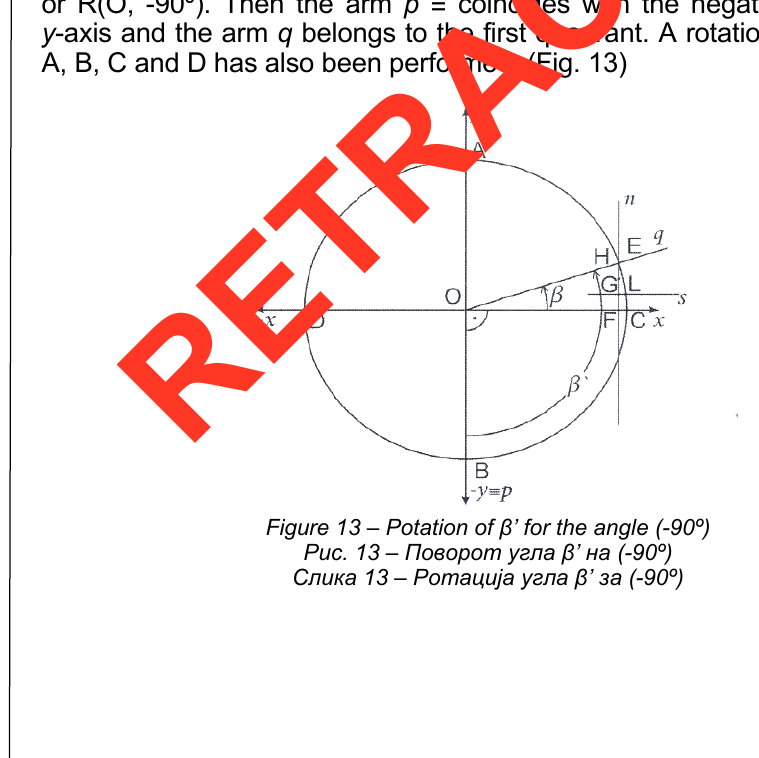
Figure 13 – Р otation of β ’ for the angle (-90º) Рис . 13 – Поворот угла β ’ на (-90º) Слика 13 – Ротација угла β ’ за